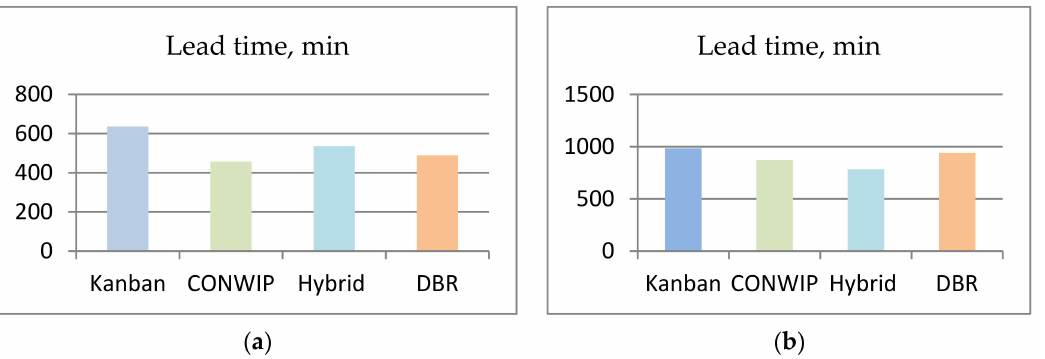
Figure 10. Comparison of the lead time for each control mechanism under the same production condition: ( a ) C V = 0.86, and T = 40 min, for the process without bottleneck and WIP = 15; ( b ) C V = 0.86 and T = 40 min, for the process with bottleneck and WIP =